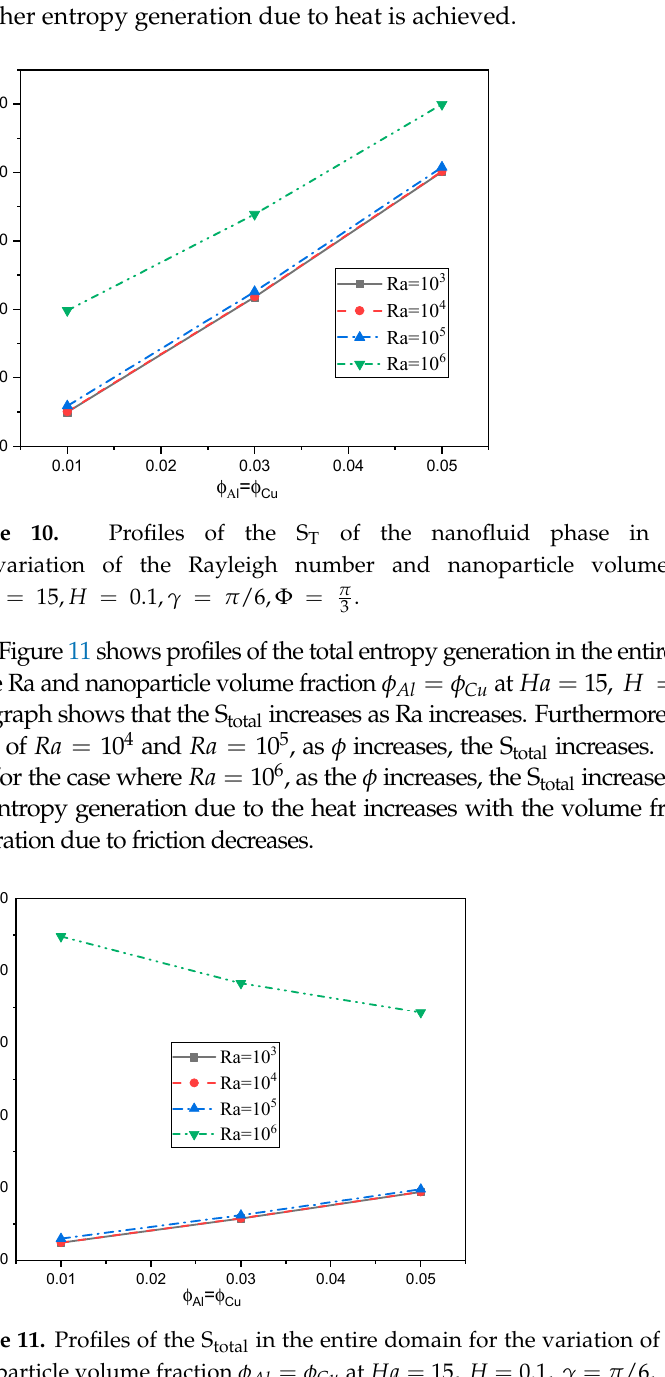
. . 3 (cid:2871) (cid:2871)